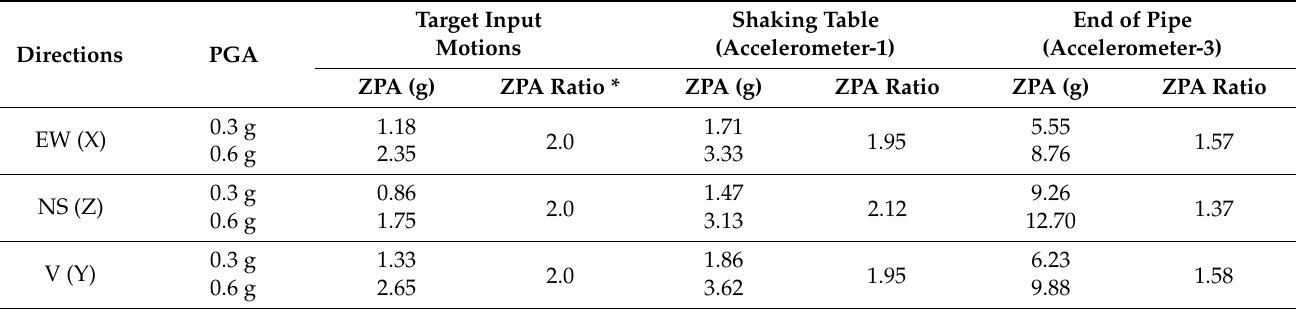
Table 7. Test results of ZPA